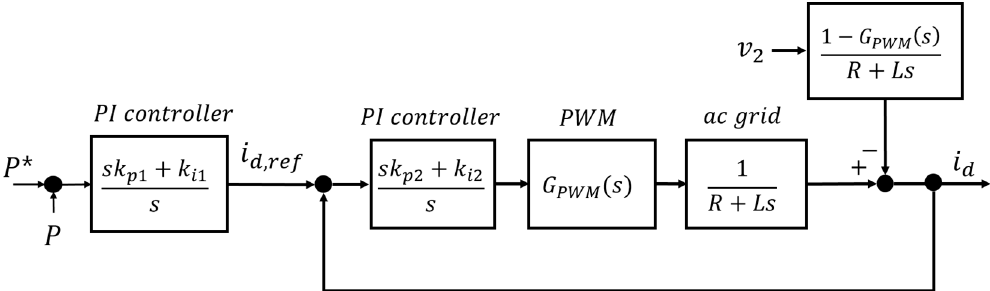
Figure 3. D-axis current control structure of the VSC; PI: Proportional and Integral.